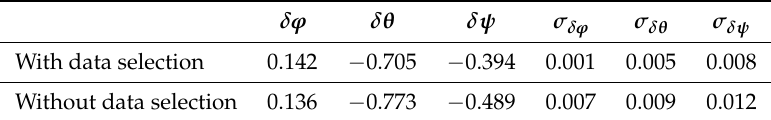
Table 2. Values of boresight (all values are in degrees) and result of the statistical analysis in terms of standard deviation of the estimated parameters. We can see that the standard deviation of boresight angle is larger without data